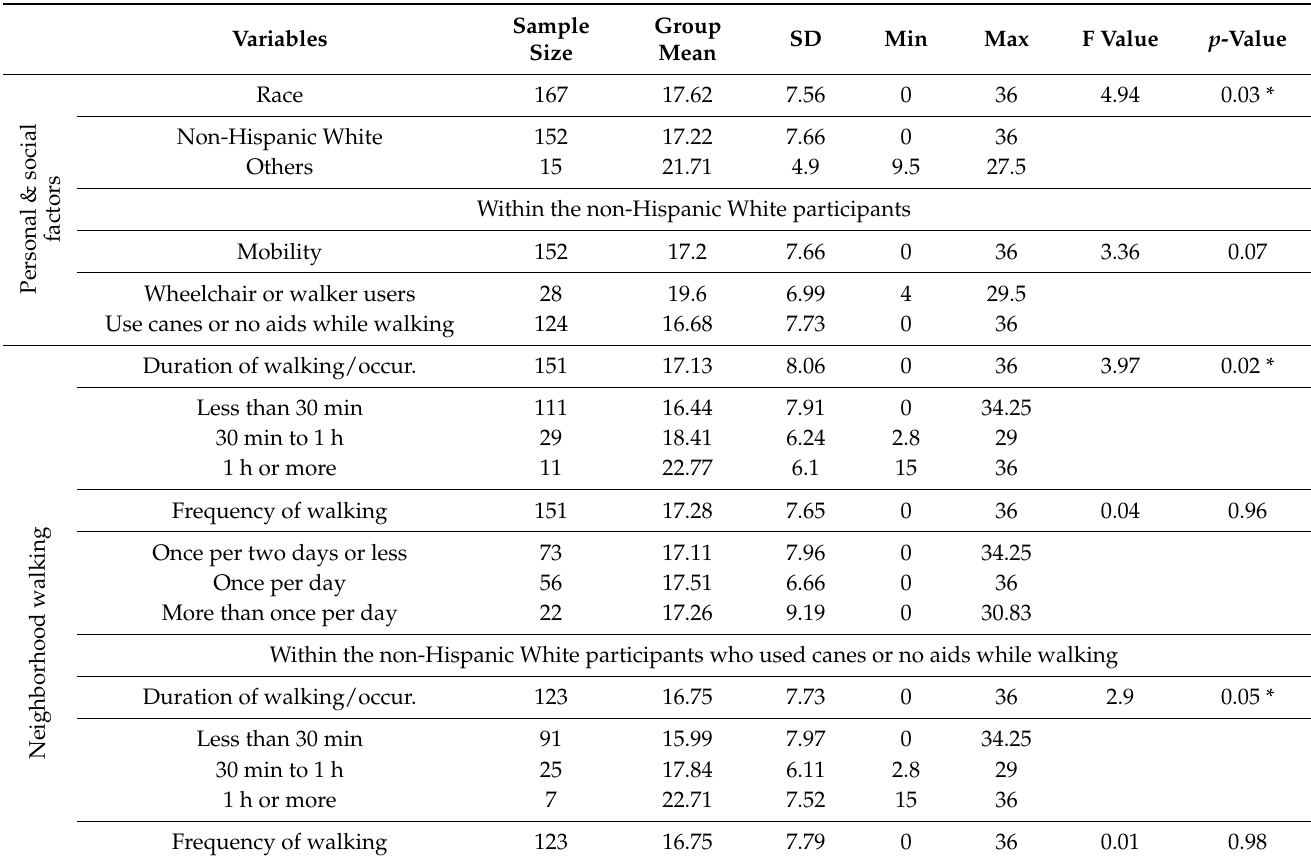
Table 2. Lengths of Aging-in-place at Home by